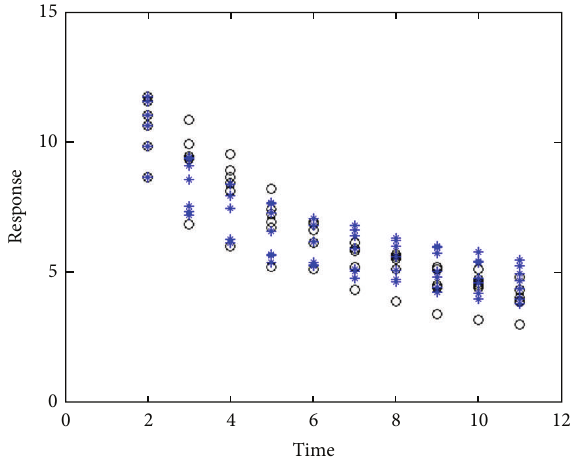
Figure 3: C-peptide concentrations data are given by the circle and prediction data are given by the